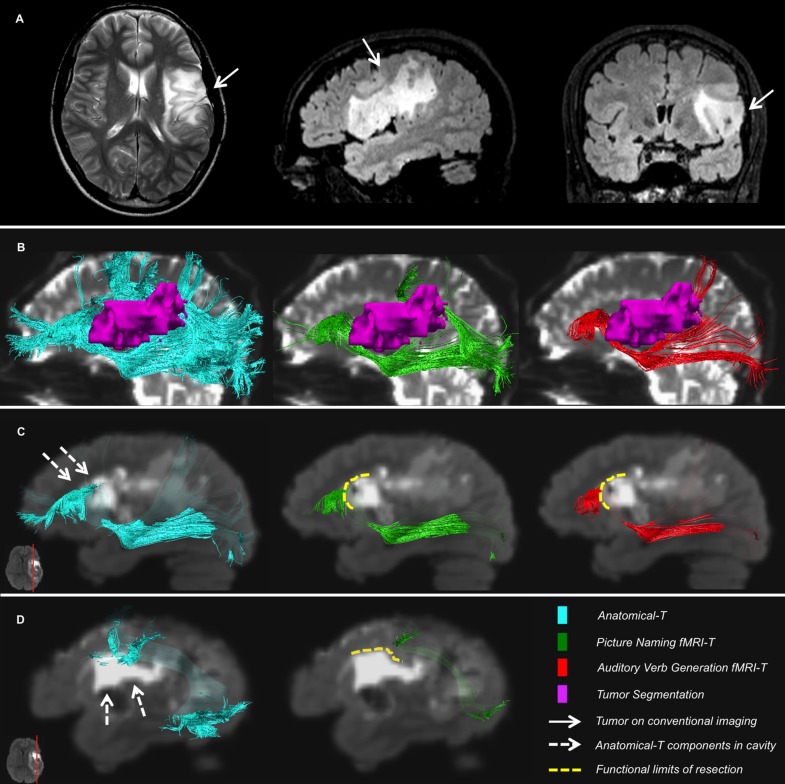
Representative case of a patient. (A) T2-weighted and FLAIR images showing the tumor site; (B) Relationships between IFOF, AF and the tumor on preoperative B0; (C,D) Postoperative FLAIR registered to preoperative diffusion space shows components of Anatomical-T IFOF (C) and AF (D) located inside the surgical cavity, whereas fMRI-T IFOF (C) and AF (D) are aligned to the functional limits of resection.